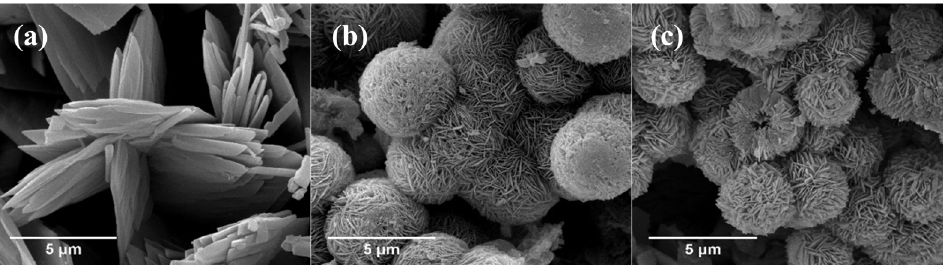
Figure 6. SEM images of ZnO@MOF-46(Zn) using ZnO(1) (cube) ( a ), ZnO(2) (cuboctahedron) ( b ), and ZnO(3) (octahedron) ( c ) as the precursor. and ZnO(3) (octahedron) ( c ) as the